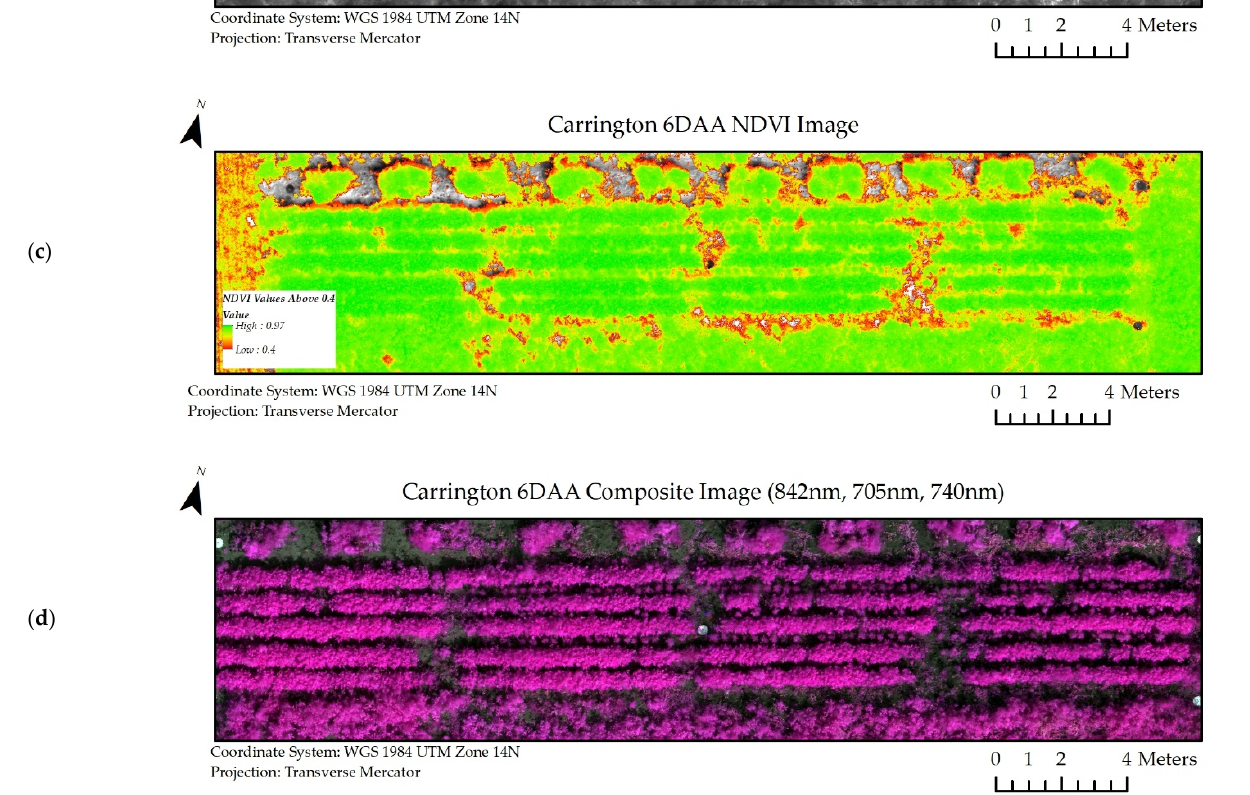
Figure 6. Image datasets from Carrington at 6 days after glyphosate application (6 DAA) used in classification models. ( a ) Shapefiles denoting species and biotype location within the scene. ( b ) Thermal image dataset. ( c ) NDVI image dataset. ( d ) Composite Image Dataset for all wavelengths of the multispectral image (RRPW: Redroot Pigweed).